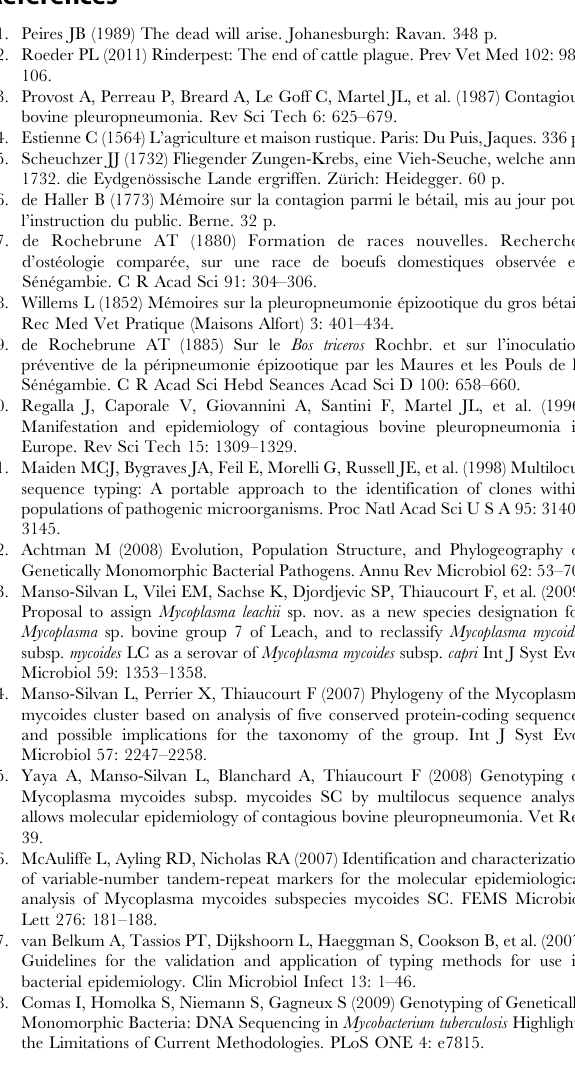
Figure S3 Alignment of 62 concatenated core genes of 20 MmmSC strains and an Mmc outgroup. Input file for phylogenetic analysis using PhyML. Figure S4 Alignment of polymorphic sites of 62 concat- enated core genes from 20 MmmSC strains. Multifasta file containing only polymorphic bases, used for analysis with the PHYLIP package. Figure S5 Input file for BEAST analysis. Xml file generated by the BEAUTi software. This file contains all sequence